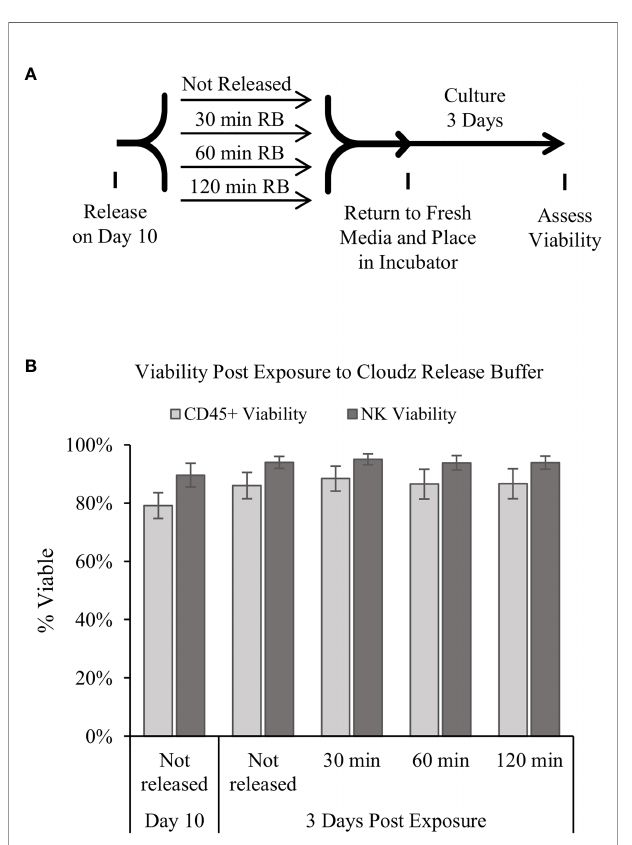
FIGURE 4 | Release of the cells and extended culture. (A) Diagram of the protocol used to test how extended periods in the release buffer affect cells. Samples were mixed, and then an equal volume of 1× release buffer was added to the cells to release the Cloudz. Samples were incubated in this release buffer for either 30, 60, or 120 min, then washed, returned to growth media, and cultured for 3 days. (B) The viability of either all CD45 + cells (light gray bars) or NK cells alone (dark gray bars). Data represent the mean ± SD from 3 separate donors. The results suggest that extended incubation has no effect on viability compared with a sample that was not